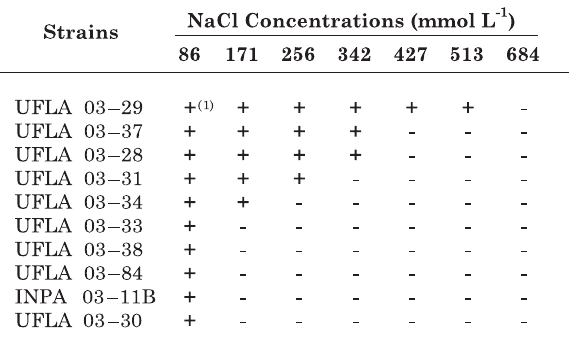
Table 3. Growth of Bradyrhizobium strains